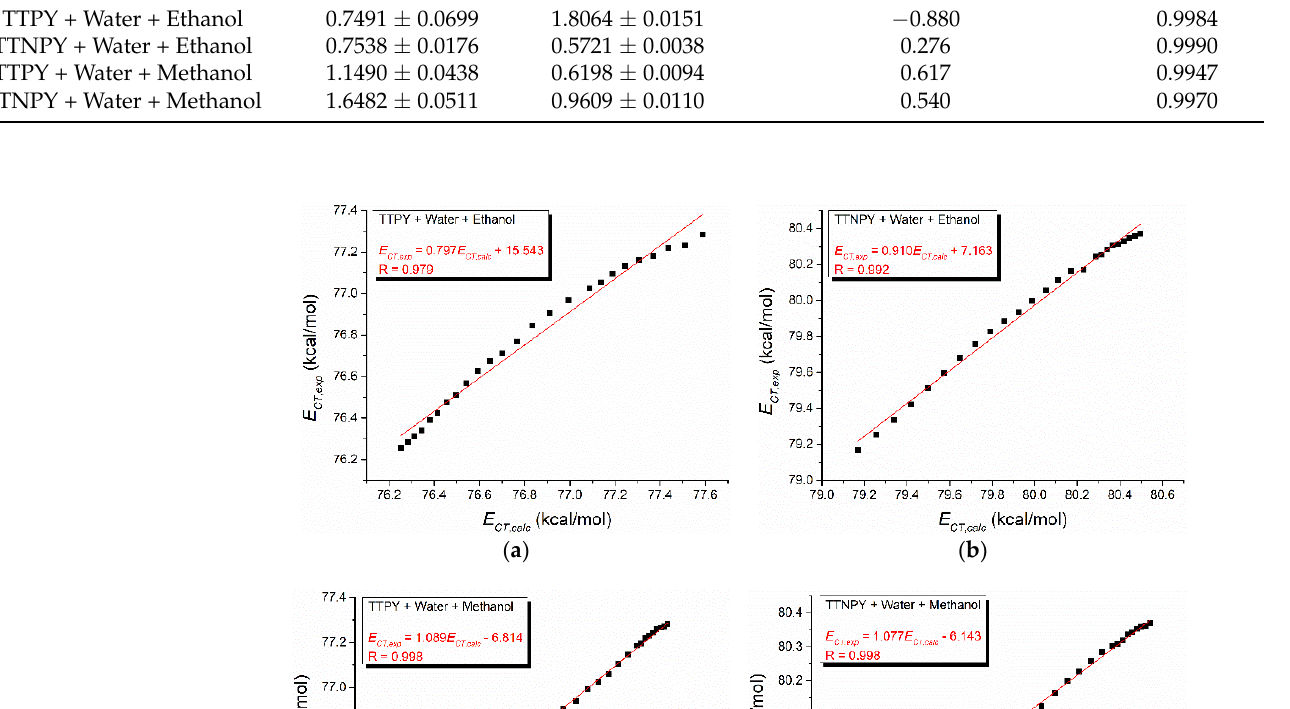
Suppan’s model predicts the charge transfer energies with a high accuracy for the